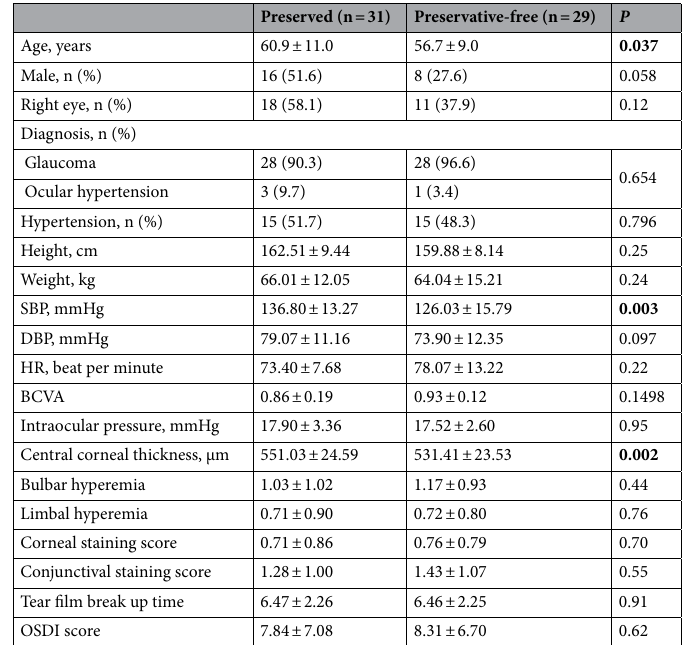
Intention-to-treat set Per-protocol Variables